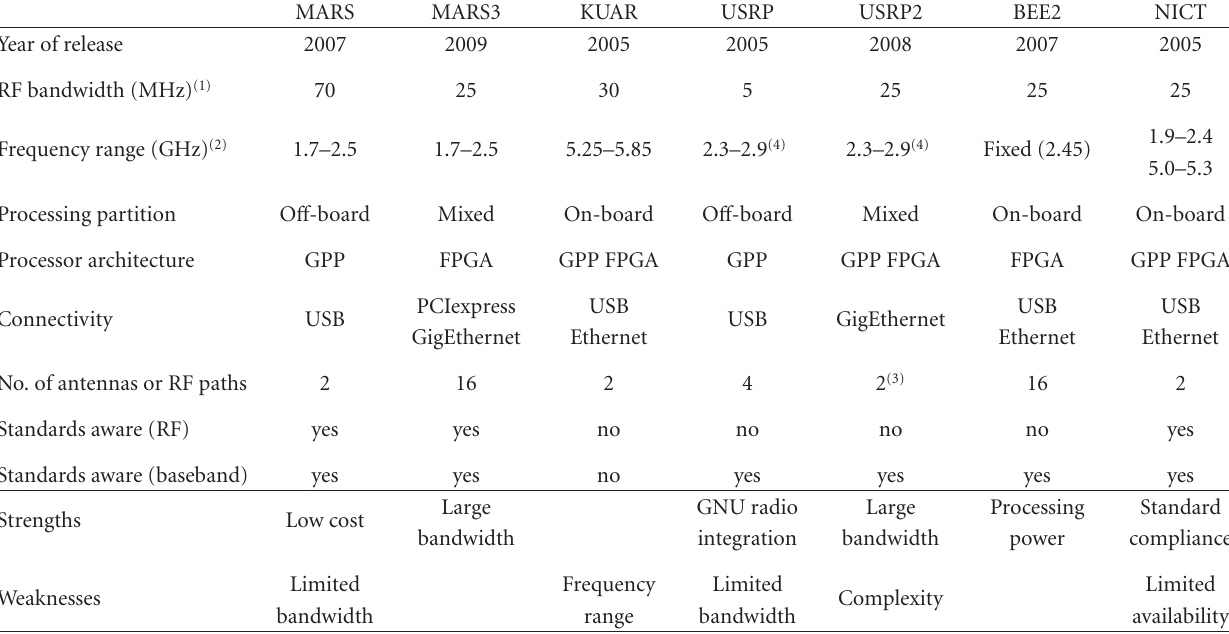
Table 2: Comparison of available SDR